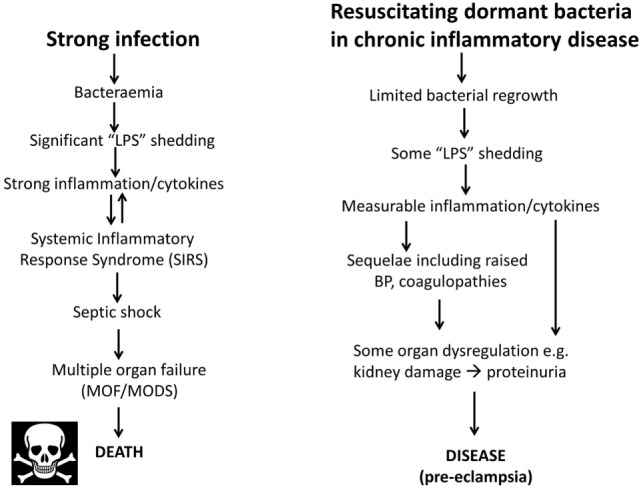
Preeclampsia bears some similarities to and may be considered as a milder form of, the changes that occur during genuine sepsis leading to a systematic inflammatory response syndrome, septic shock, and multiple organ dysfunction.